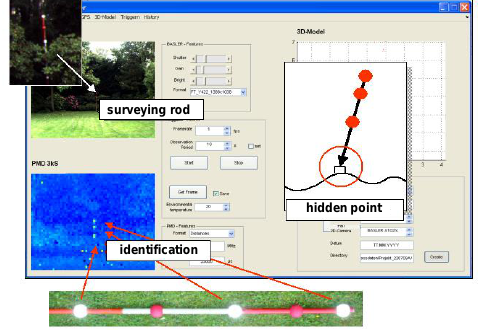
Figure 5 Automatic recognition of signalized